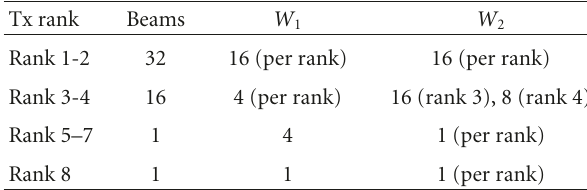
Table 2: Codebook design in LTE Advanced for 8-transmit ante-